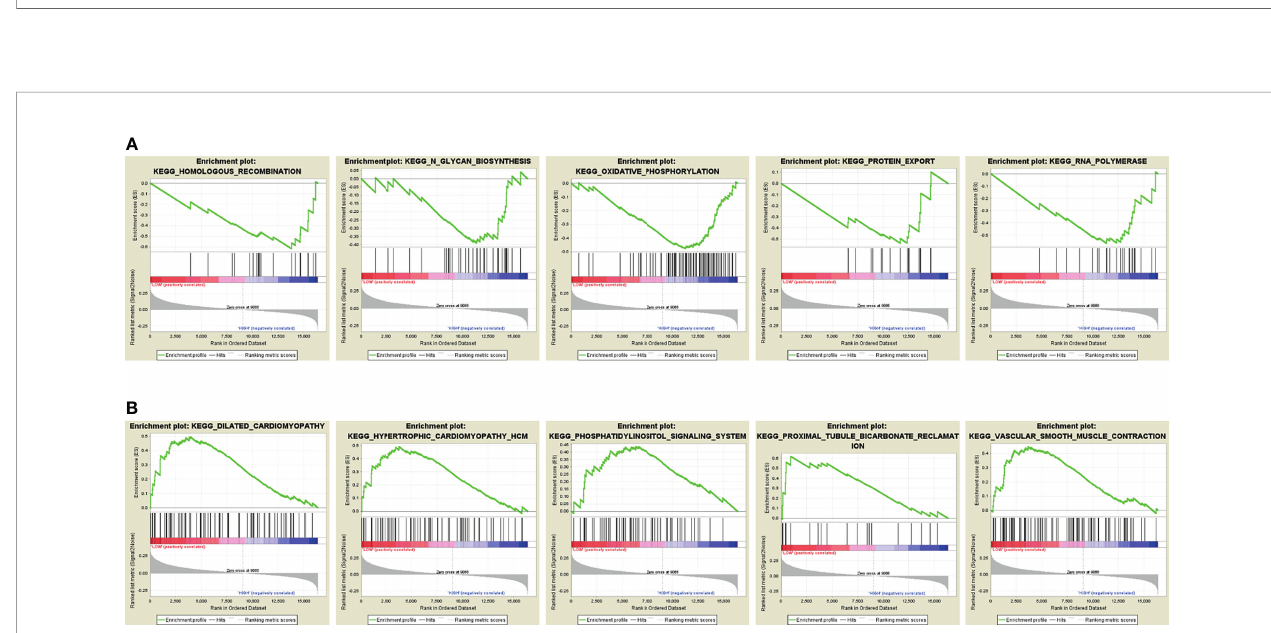
FIGURE 4 | (A) The nomogram for predicting the 1-, 2-, and 3- year relapse-free survival in breast cancer patients, based on the autophagy-related 4-gene signature selection and clinical factors. (B) The 1-, 2- and 3-year calibration curves were derived from the nomogram,